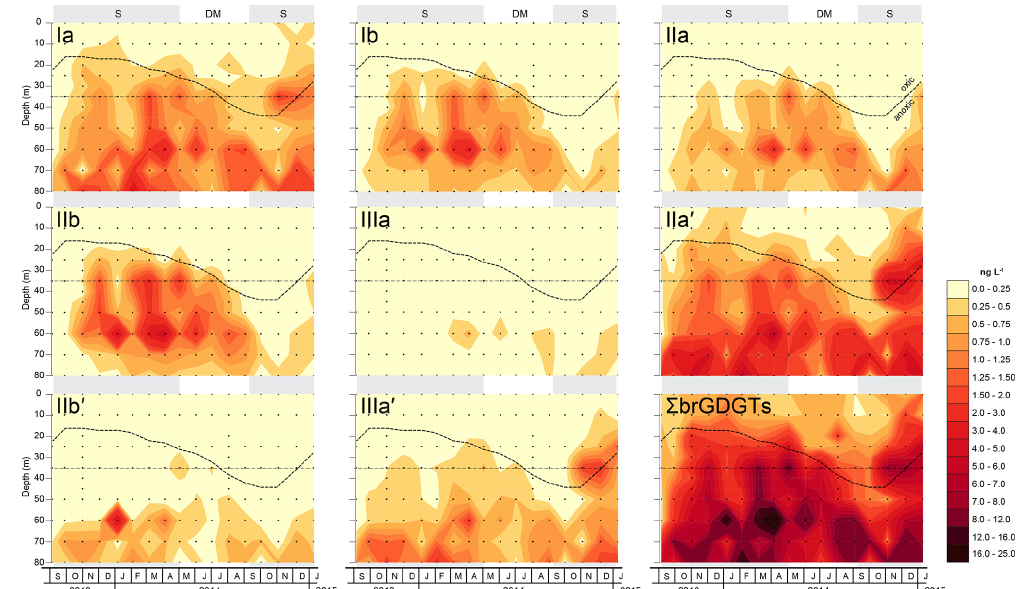
Figure 4. Depth-interpolated concentrations (in ngL − 1 ) of the summed and eight most common individual brGDGT compounds in SPM collected at eight depth intervals (occasionally 13) between 0 and 80m in Lake Chala, at approximately monthly intervals between Septem- ber 2013 and January 2015. Also indicated is the varying position of the oxycline (bold stippled line) in relation to the static position of the sediment trap at 35m depth (thin dashed line), which separates the SPM abovetrap and SPM belowtrap zones. Grey background shading indicates the seasonal periods of upper water column stratification (S) and deep mixing (DM), as in Fig. 3.